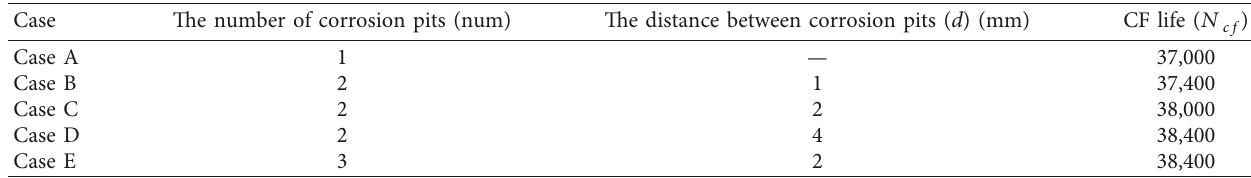
Figure 25: Steel wire model with the different stepped multifatigue sources (view cut: x � 0mm): (a) Case A; (b) Case B; (c) Case C; (d) Case D; (e) Case E. Table 4: CF life high-strength steel wires with different stepped multifatigue sources.